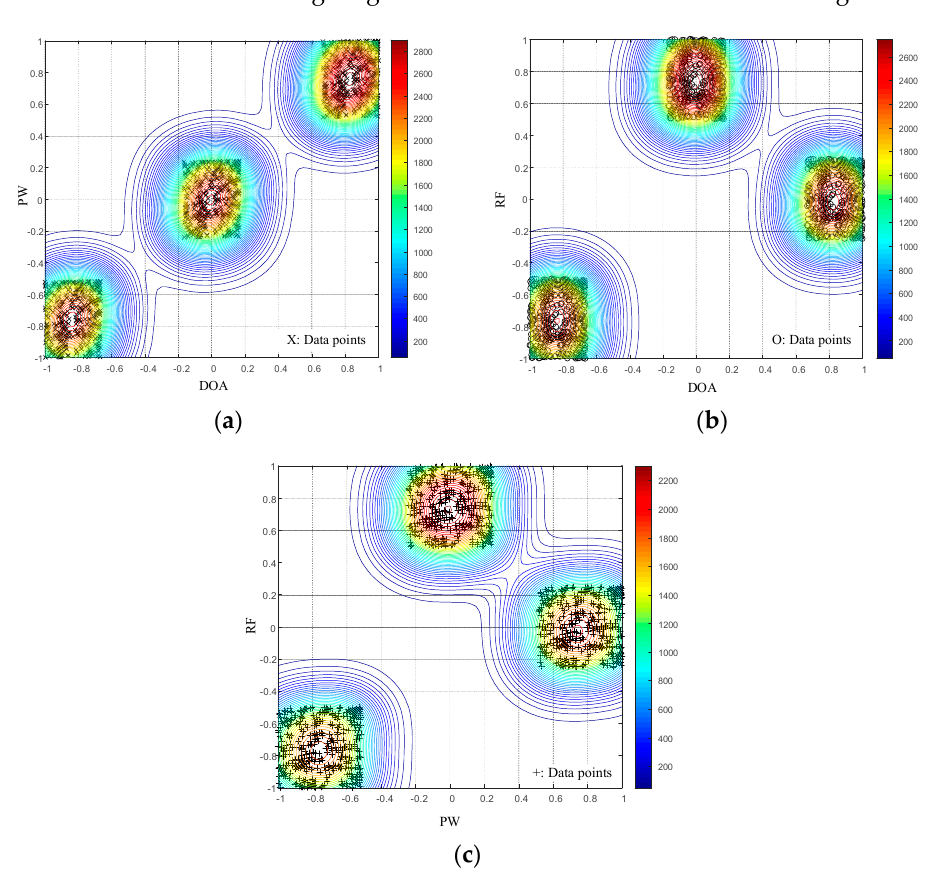
Figure 4. Two-dimensional distribution of the proposed signal parameter’s equipotential lines with three-dimensional pseudo-center wide-agile composite modulation. ( a ) Two-dimensional diagram of the PW-DOA equipotential line. ( b ) Two-dimensional diagram of the RF-DOA equipotential line. ( c ) Two-dimensional diagram of the RF-PW equipotential line.